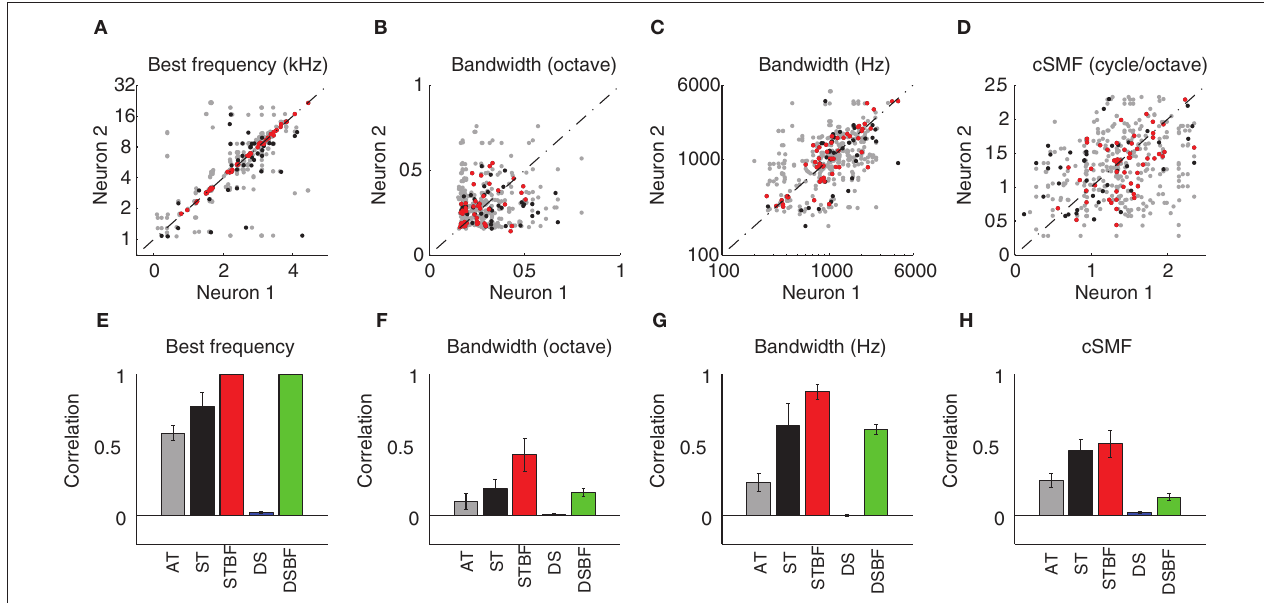
FIGURE 4 | Neighboring ICC neurons share similar spectral preferences. (A–D) Scatter plots showing the spectral STRF parameters ( A , Best Frequency; B , Bandwidth in octave; C , Bandwidth in Hz; D , cSMF) of neighboring single units (neuron 1 and 2). For each of the STRF parameters the data was partitioned into three experimental groups that depend on the spatial proximity and BF match. The experimental groups consist of neuron pairs found on adjacent tetrodes (AT, gray ; 150 μ m tetrode separation), neuron pairs detected on the same tetrode (ST, black ), and same tetrode pairs that were matched in best frequency (STBF, red ; < 0.1 octave BF